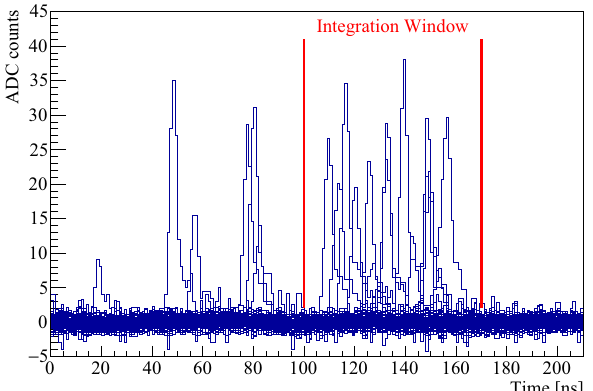
Fig. 3 TwohundredconsecutivewaveformsfromthePMToverlapped with each other measured with the crystal in